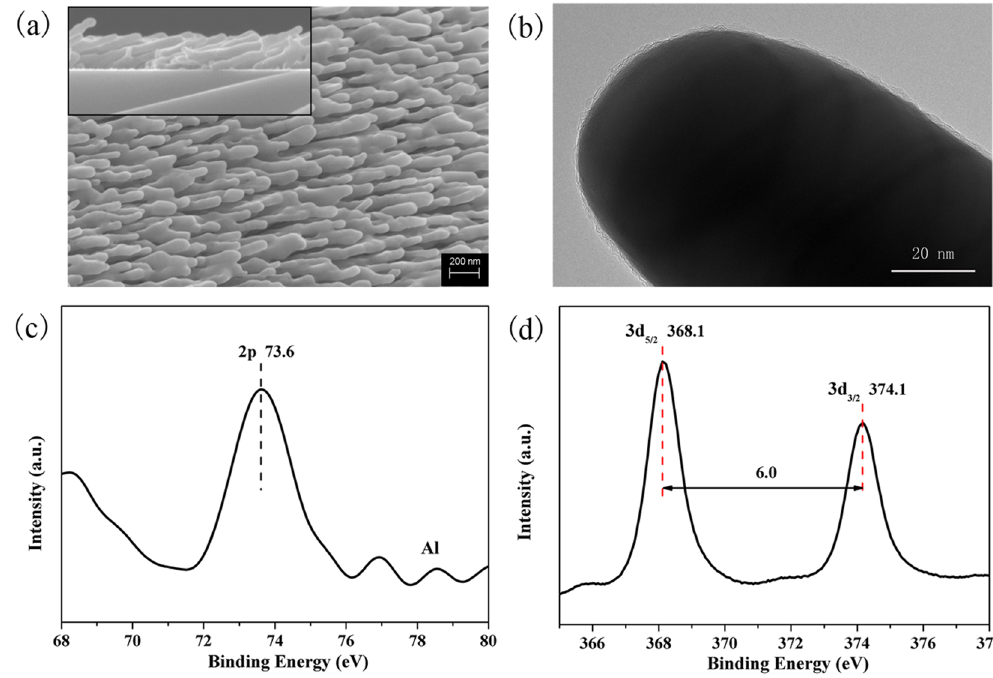
Figure 1. ( a ) Top-view SEM image of Ag@Al 2 O 3 nanorods; inset is a corresponding side-view SEM image. ( b ) HRTEM image of the Ag@Al 2 O3 nanorods. ( c ) A typical Al 2p XPS spectrum of the Al 2 O 3 layer. ( d ) Ag 3d 5/2 and Ag 3d 3/2 XPS spectra of Ag@Al 2 O 3